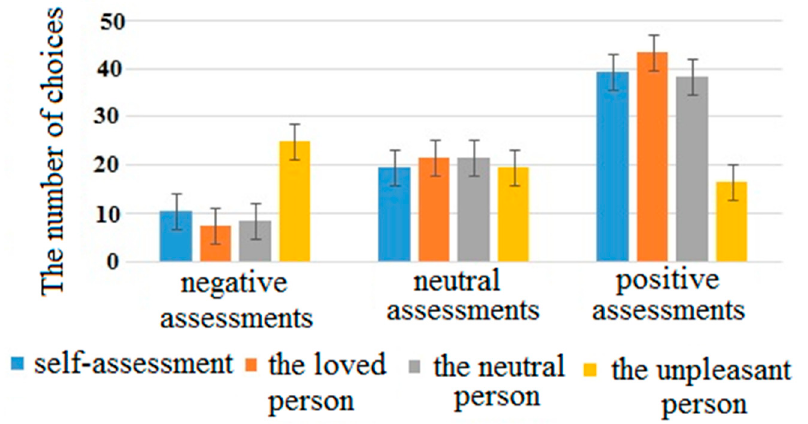
Figure 1. The number of choices for di ff erent attribution’s objects and assessments averaged across all participants.